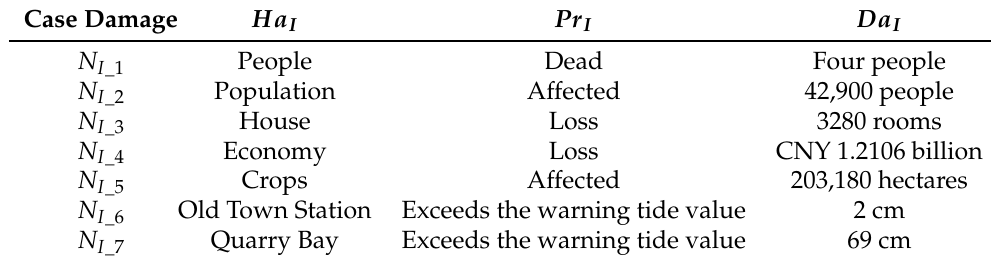
Table 7. Label information V I of storm surge disaster case no. 1.